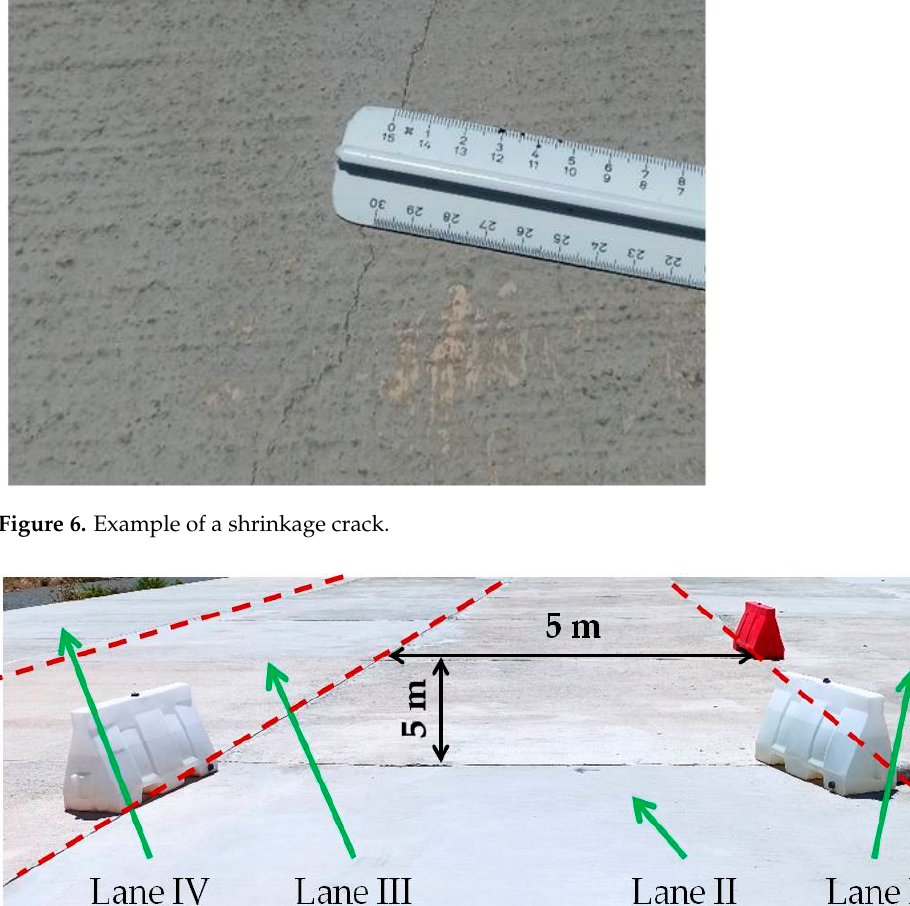
Figure 7. Investigation area of the so far constructed concrete pavement. Each lane included square concrete slabs with dimensions of 5 × 5 m and the total investigation area was 1800 m 2 .